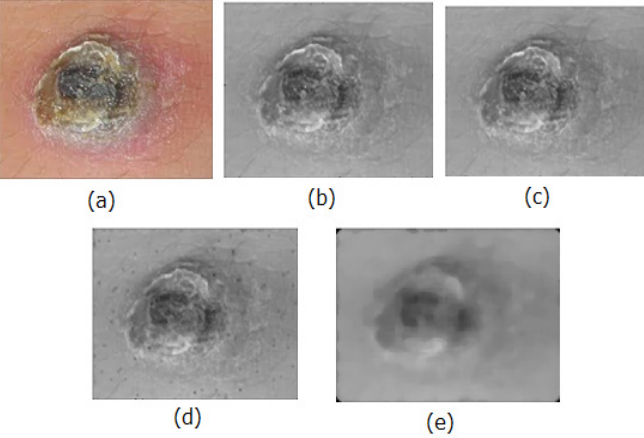
Figure 3. Results of sample image-1: ( a ) original image, ( b ) traditional median filter, ( c ) proposed range method, ( d ) proposed Fuzzy Relational method, ( e ) proposed Similarity Coefficient method.